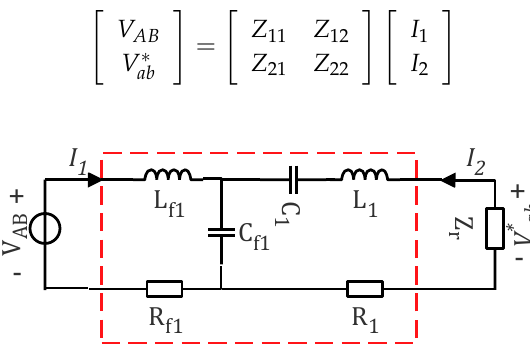
Figure 5. Two port network of the proposed